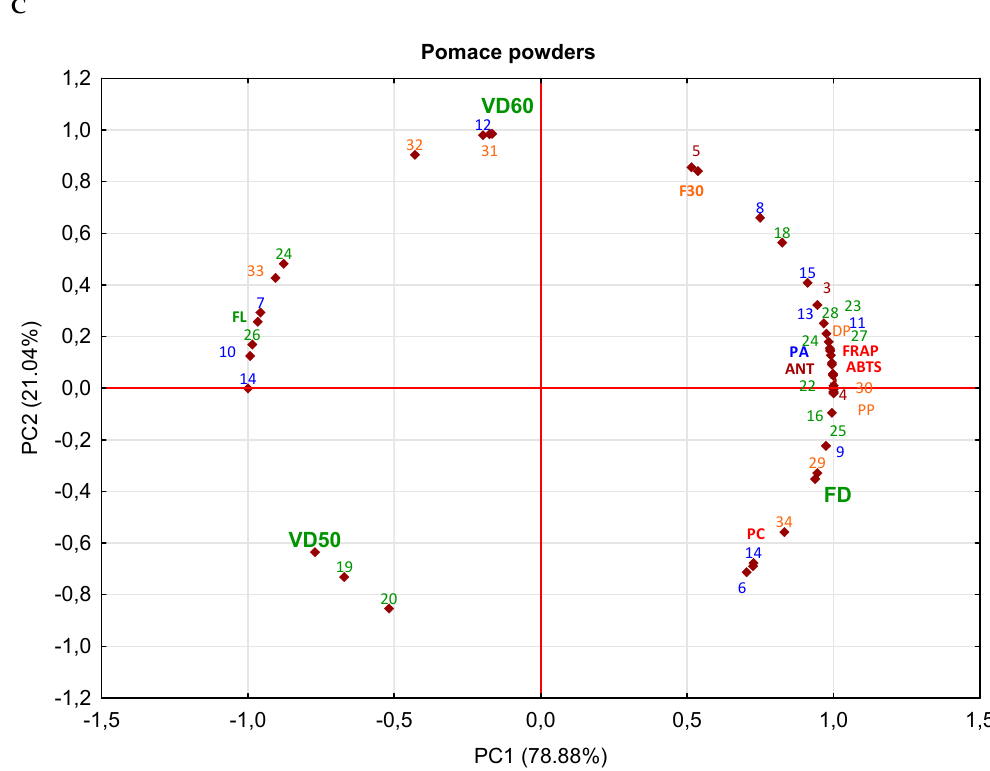
Figure 3. Principal component analysis (PCA) of the impact of drying method on phytochemicals in fruit ( A ), juice ( B ), pomace ( C ) powders. Abbreviations: FD, freeze-drying; VD / 50, vacuum-drying in 50 ◦ C; VD / 60, vacuum-drying in 60 ◦ C; ANT—sum of